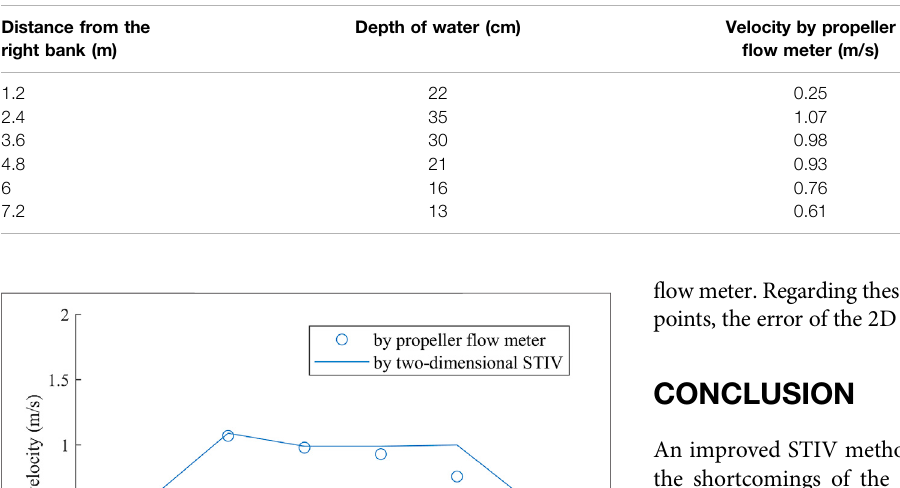
Depth of water (cm) Velocity by propeller